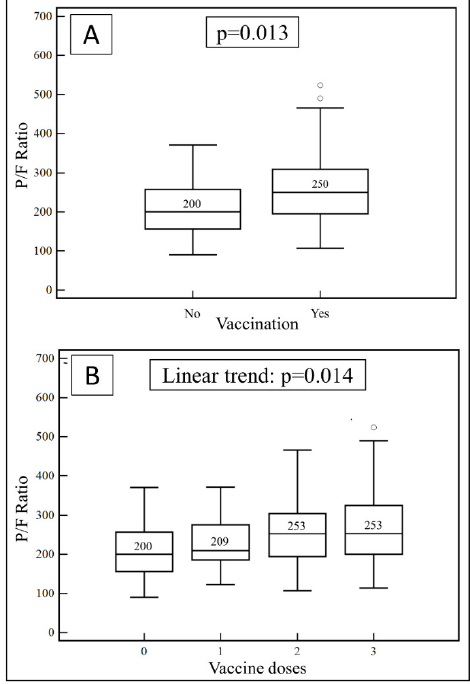
Figure 1. ( A ) PaO 2 /FiO 2 ratio values on admission in non-vaccinated and vaccinated COVID-19 patients. ( B ) PaO 2 /FiO 2 ratio values on admission on the basis of vaccine doses number administered to COVID-19 patients.